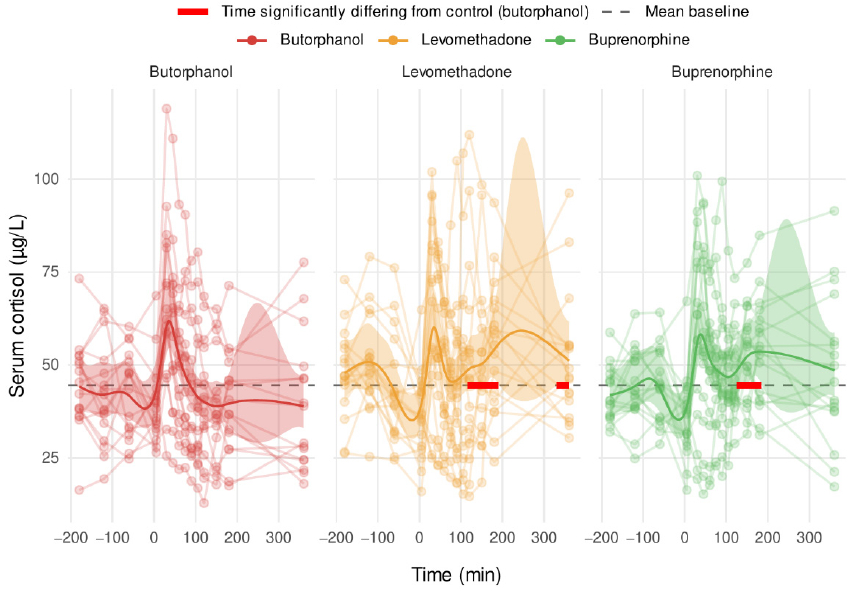
Figure 4. Serum cortisol concentrations of the groups BUT, BUP and LEV over time. The solid line represents the smoothed time course as obtained using a generalized linear model. Its 95% confidence interval is shown as a shaded area in the background. For BUP and LEV, the time windows significantly differing from the control group BUT are represented as red rectangles. Finally, the mean baseline is represented as a dashed black line.